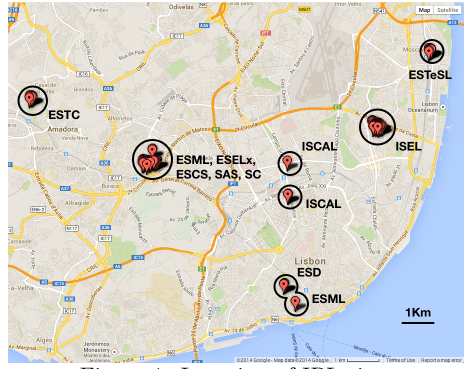
Figure 1: Location of IPL